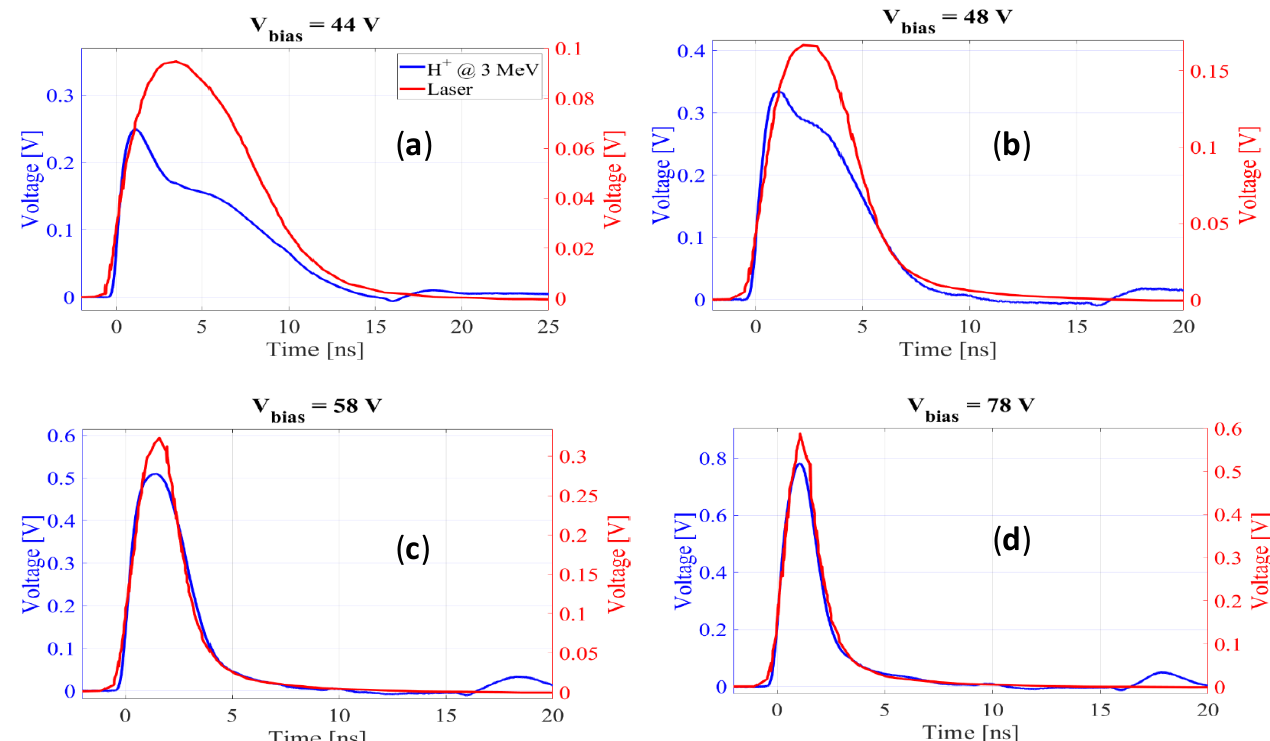
Figure 13. Comparison of TRIBIC and TCT-laser waveforms at different voltages at normal incidence (0°). ( a ) 44V; ( b ) 48 V; ( c ) 58 V and ( d ) 78V.